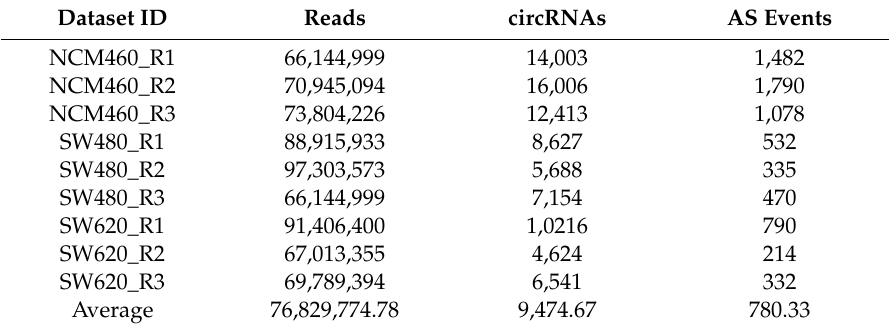
Table 1. Table reporting the number of RNA-Seq paired reads analyzed, the number of detected circRNAs, and the number of alternative splicing (AS) events predicted by CIRI-AS. Dataset ID Reads circRNAs AS Events NCM460_R1 66,144,999